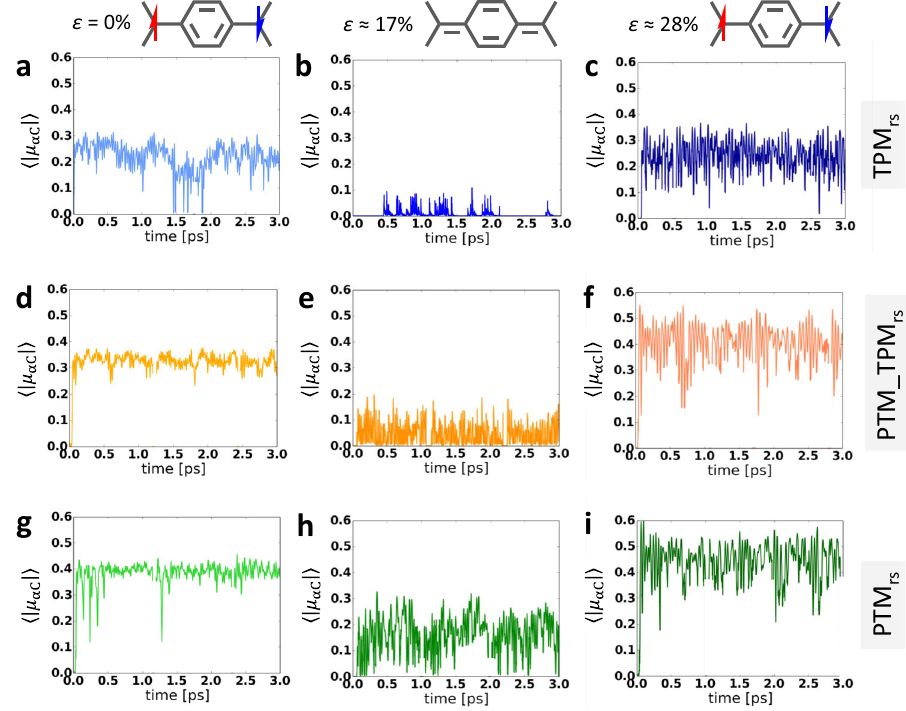
(cid:1) (cid:1) (cid:1)(cid:3) (cid:4) (cid:1) during 3 ps of AIMDS at 300 K